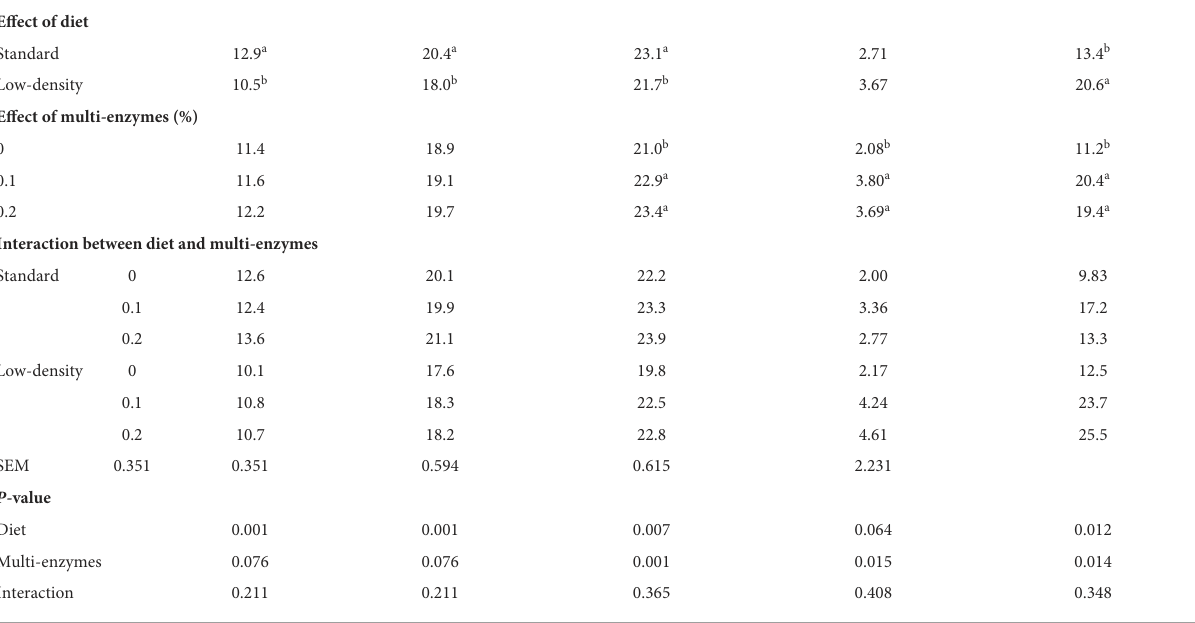
TABLE 8 Economic efficiency of broilers fed standard and low-density diets supplemented with different concentrations of multi-enzymes from 1 to 38 days of age.